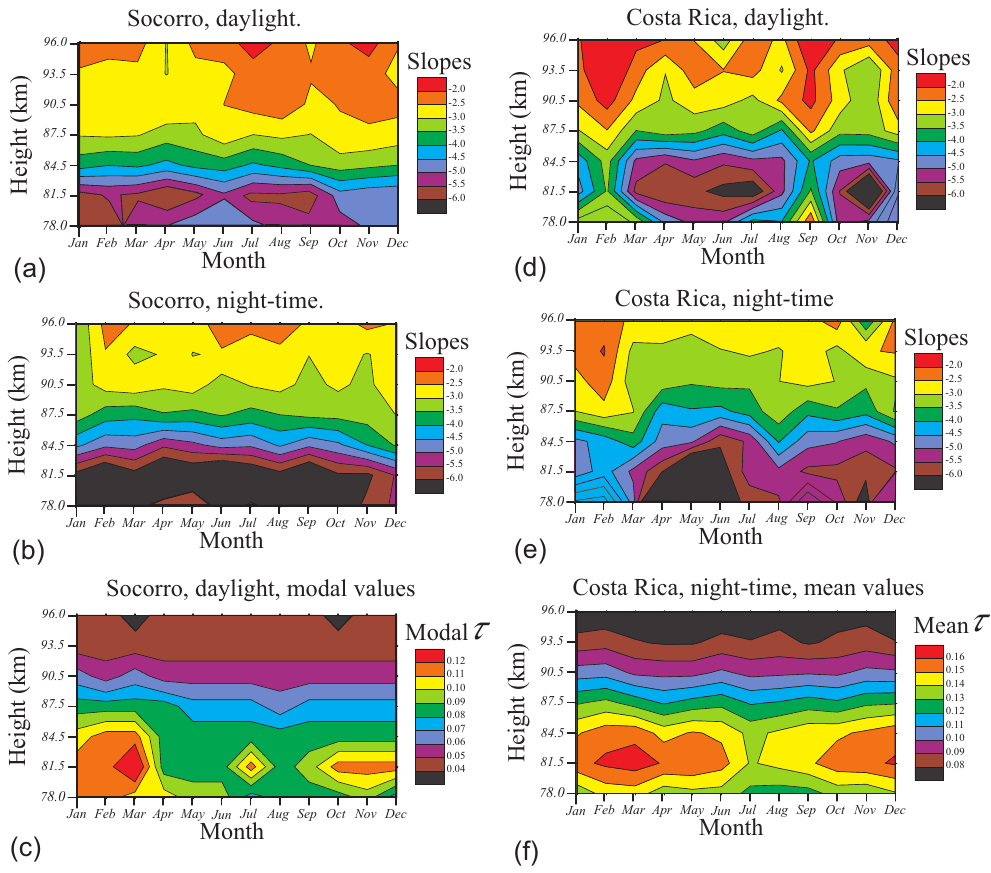
Figure 7. Panel (a) and (b) show contour plots of the slope of the tail of the CCD, as described in the text, as a function of height and month, for Socorro during daylight hours and night-time respectively. Panel (c) shows contour plots of the modes of τ during Socorro daylight. Panel (d) and (e) show contour plots of the slope of the tail of the CCD as a function of height and month for Costa Rica during daylight hours and night-time respectively. (f) shows contour plots of the mean values of τ during Costa Rica night-time. The data below 86km in (d) and (e) are discussed in the text. Graphs (c) and (f) do not pertain directly to the transitionally overdense meteors but instead apply more to the underdense ones. The purpose of displaying them is discussed in the text. Note that the ordinate shows the midpoints of the height bins; the lowest and highest bins are 4km thick, while all others are 3km